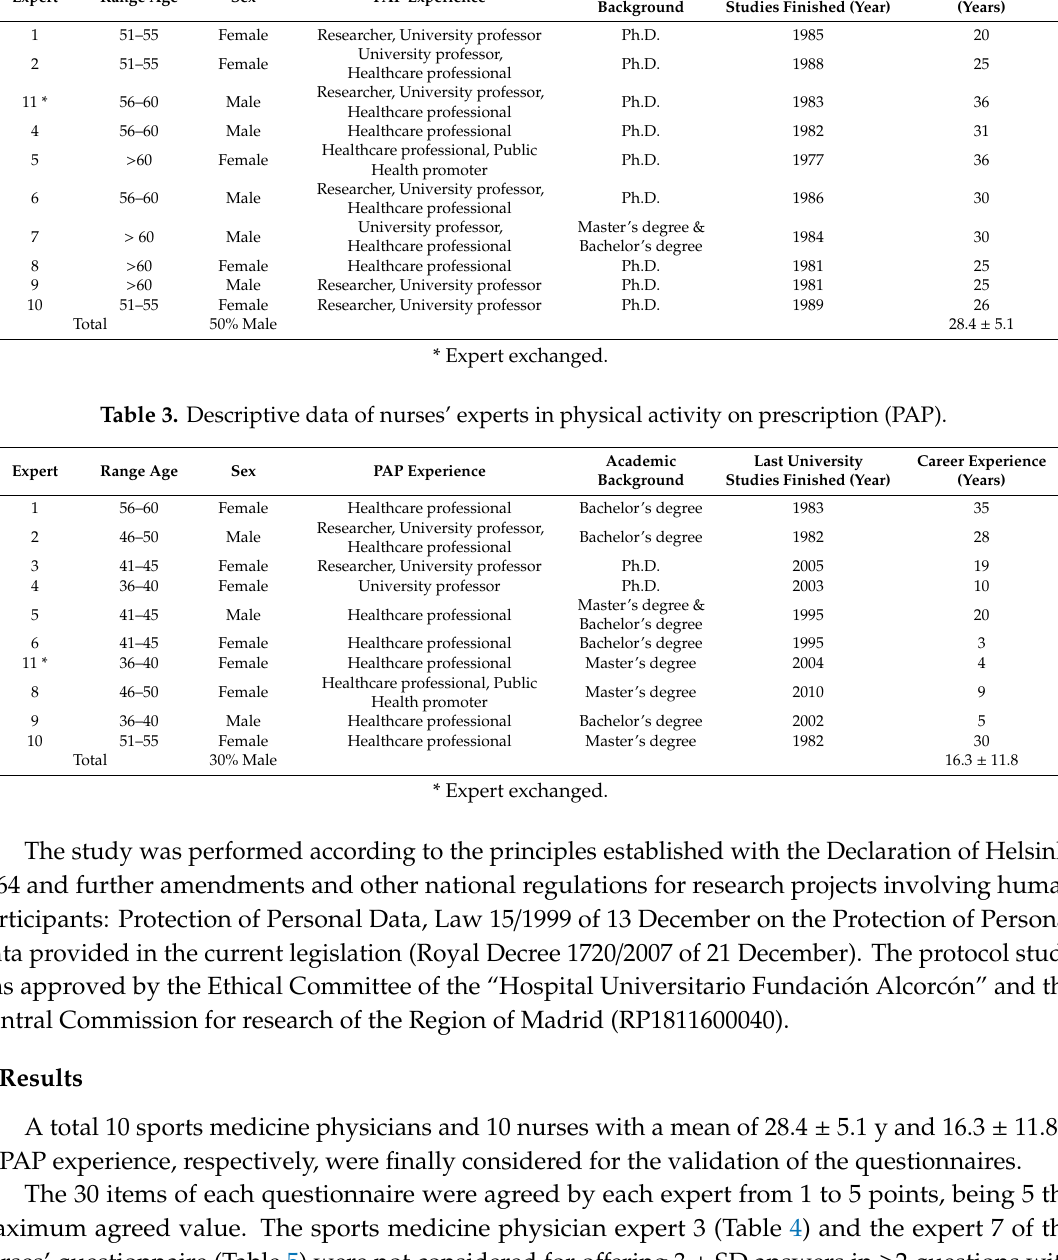
Table 2. Descriptive data of sports medicine physicians’ experts in physical activity on prescription (PAP). Expert